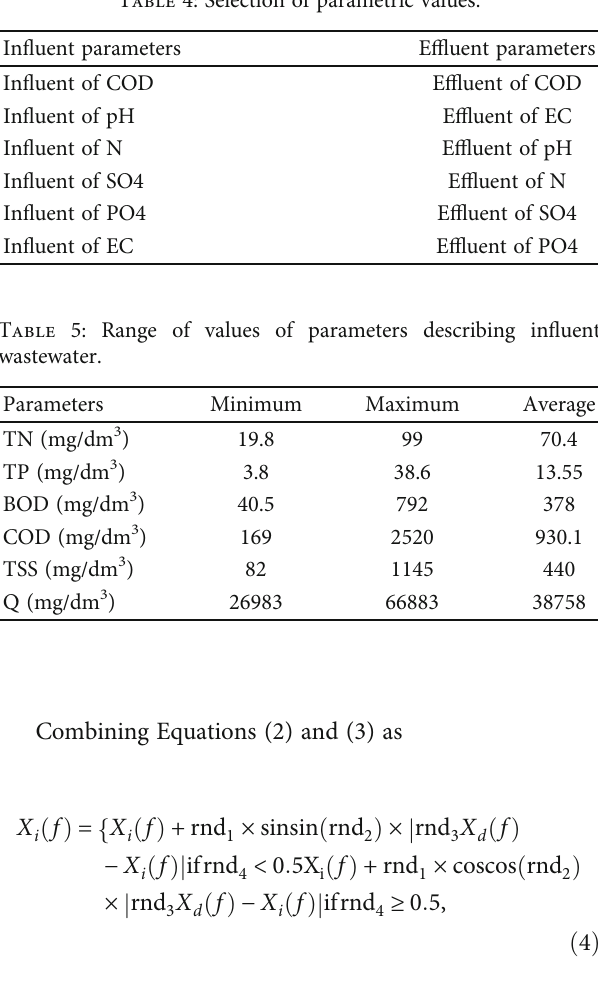
Table 4: Selection of parametric values.